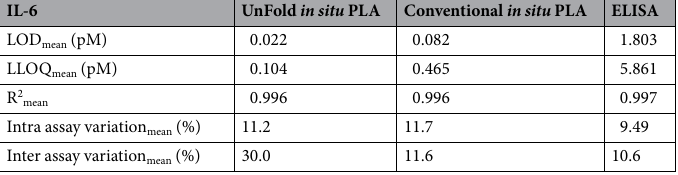
Table 2. Analytical characteristics. All values are averages of four separate experiments.